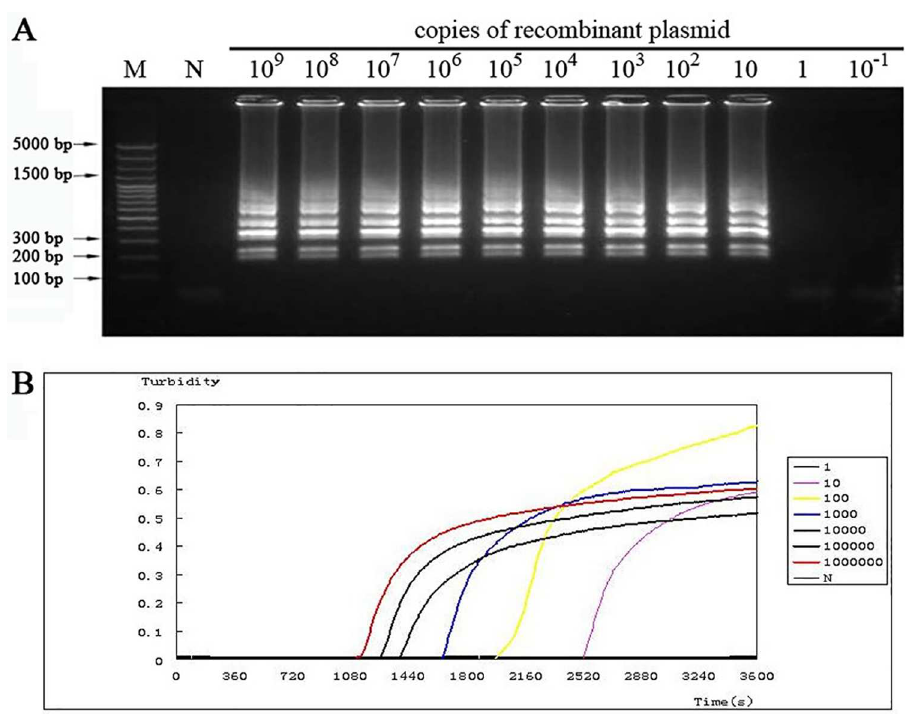
Fig 3. The sensitivity of LAMP was checked. (A) LAMP reaction with different copies of the recombinant plasmidas the template.Lane (M), DNA ladder. (B) LAMP reaction with different copies of the recombinant plasmidwas monitoredon the